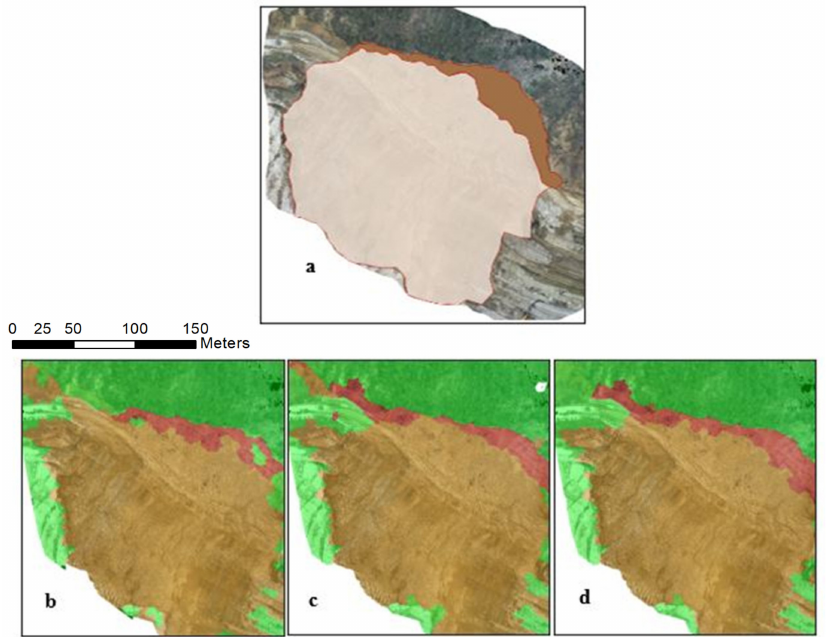
Figure 11. ( a ) Orthophoto with the reference zones overlaid; ( b ) KNN classification result; ( c ) DT clas- sification result; and ( d ) RF classification result for the “Prosilio” landslide site (green: non-affected, brown: depletion, red: scarp). Applied configuration: dataset: RGB+DSM, SP: 100, shape/color: